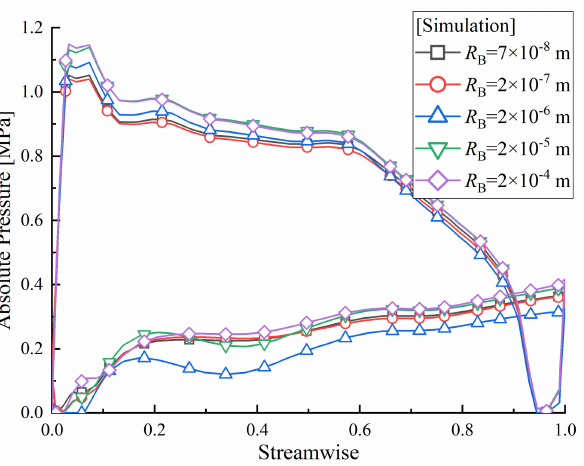
Figure 26. The absolute pressure on stator blade at stall under various mean